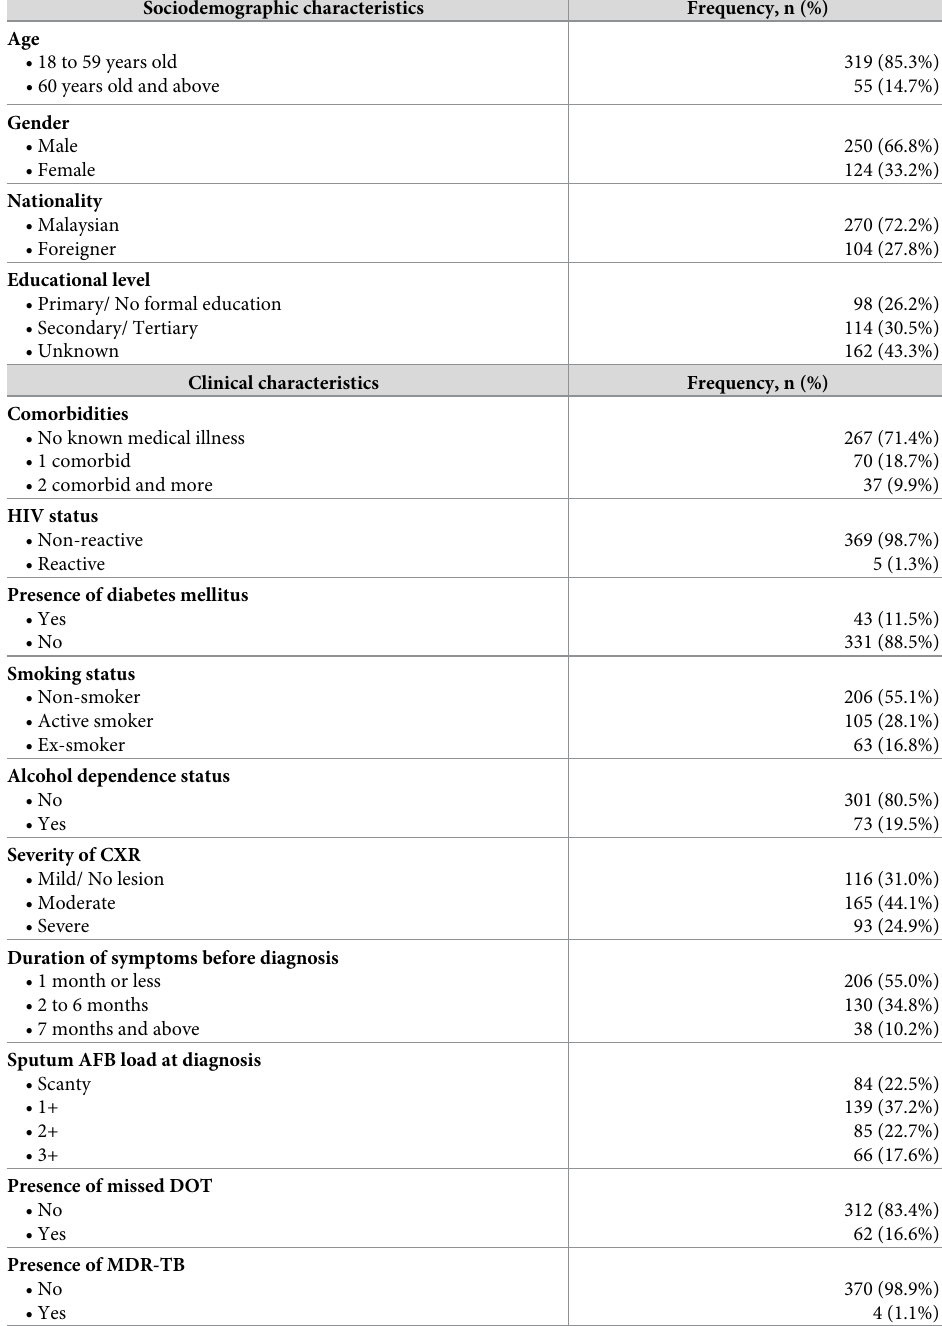
Table 1. Sociodemographic and clinical characteristics of patients smear positive pulmonary tuberculosis (N = 374). Sociodemographic